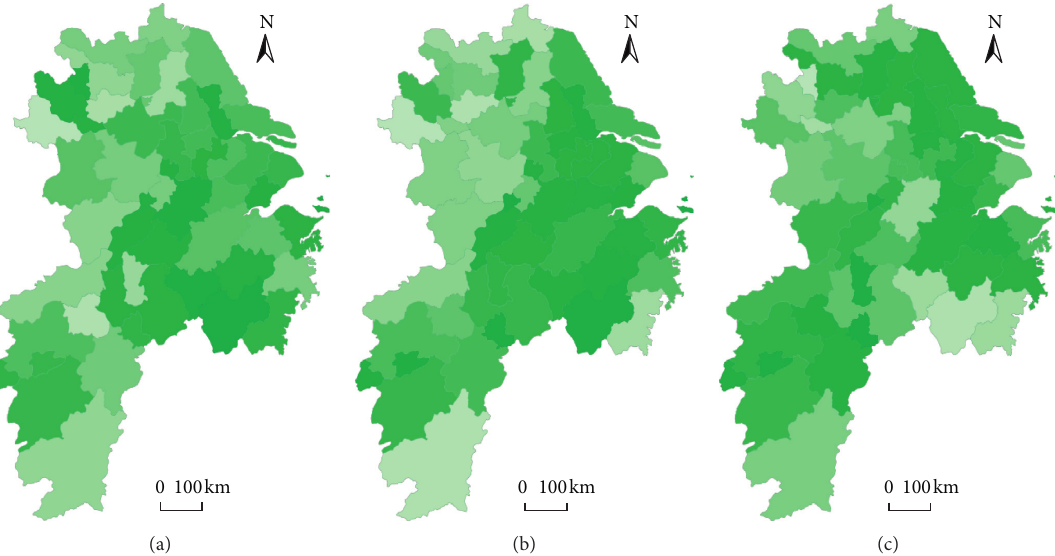
Figure 6: Illustration of the spatial dissymmetry of four provinces and one city in the lower reaches of the Yangtze river (darker colour indicates greater positive